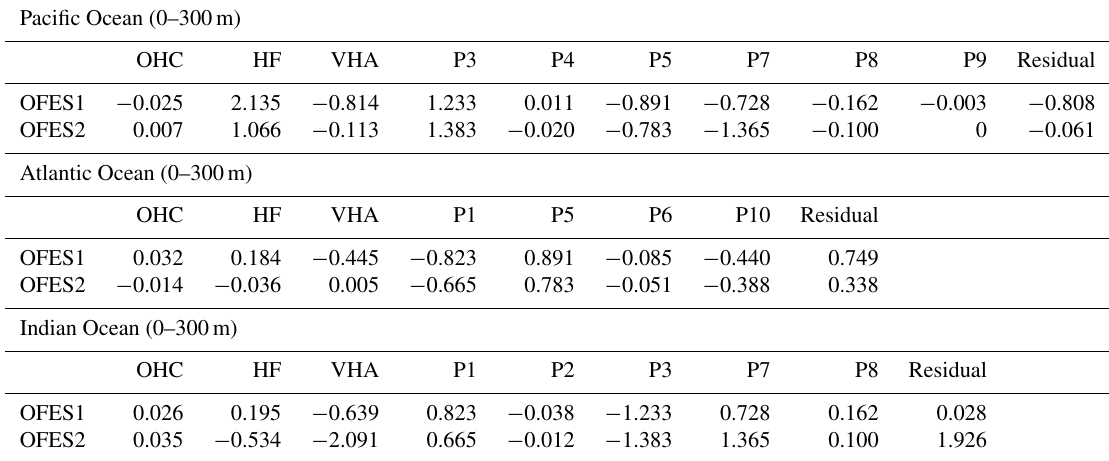
Table 2. Time-averaged OHC increasing rate, surface HF and advection of heat through the major water passages for the upper layer (0– 300m) of each basin. VHA in this table is at a depth of 300m. The residual is the difference between the OHC increase and all the heat flux into a basin, approximately the VHD. All quantities were converted to Wm − 2 applied over the entire surface of the Earth. Values smaller than 0.001 are set to 0. Positive values indicate heat gain and negative indicate heat